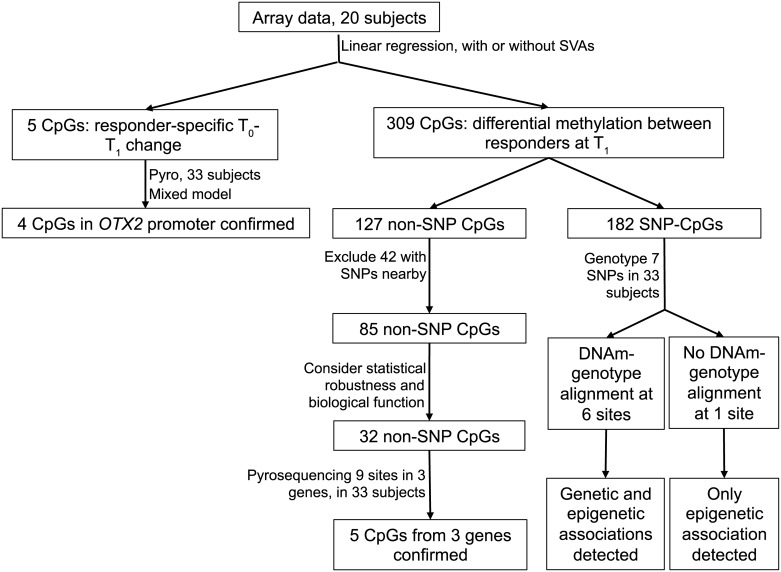
Analysis flowchart.